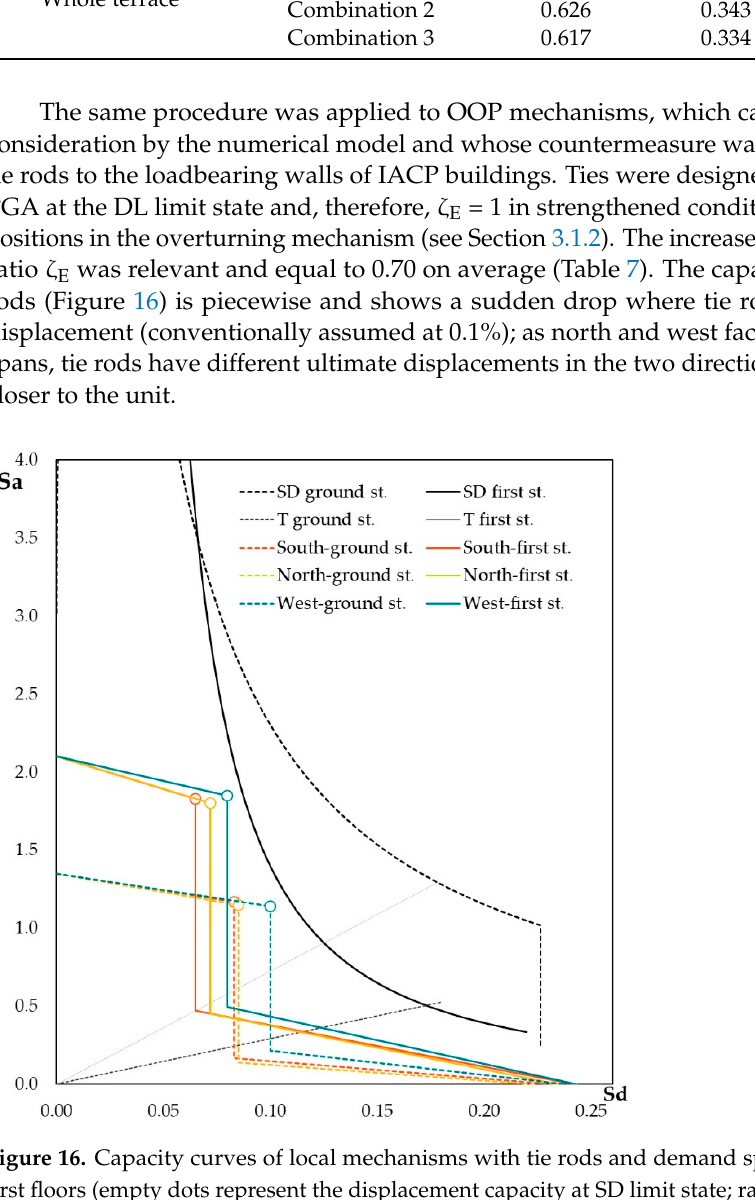
Table 7. Performance ratios ζ E at DL and SD limit states for single-unit model in as-built conditions according to kinematic analyses.